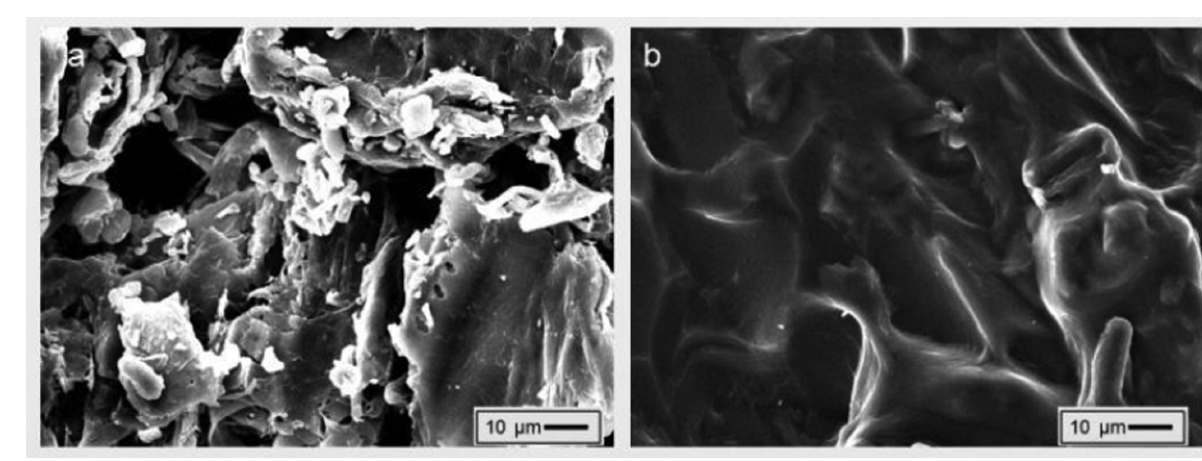
Figure 5: SEM images of SC (a) and SC-g-PAA/PAM/Urea